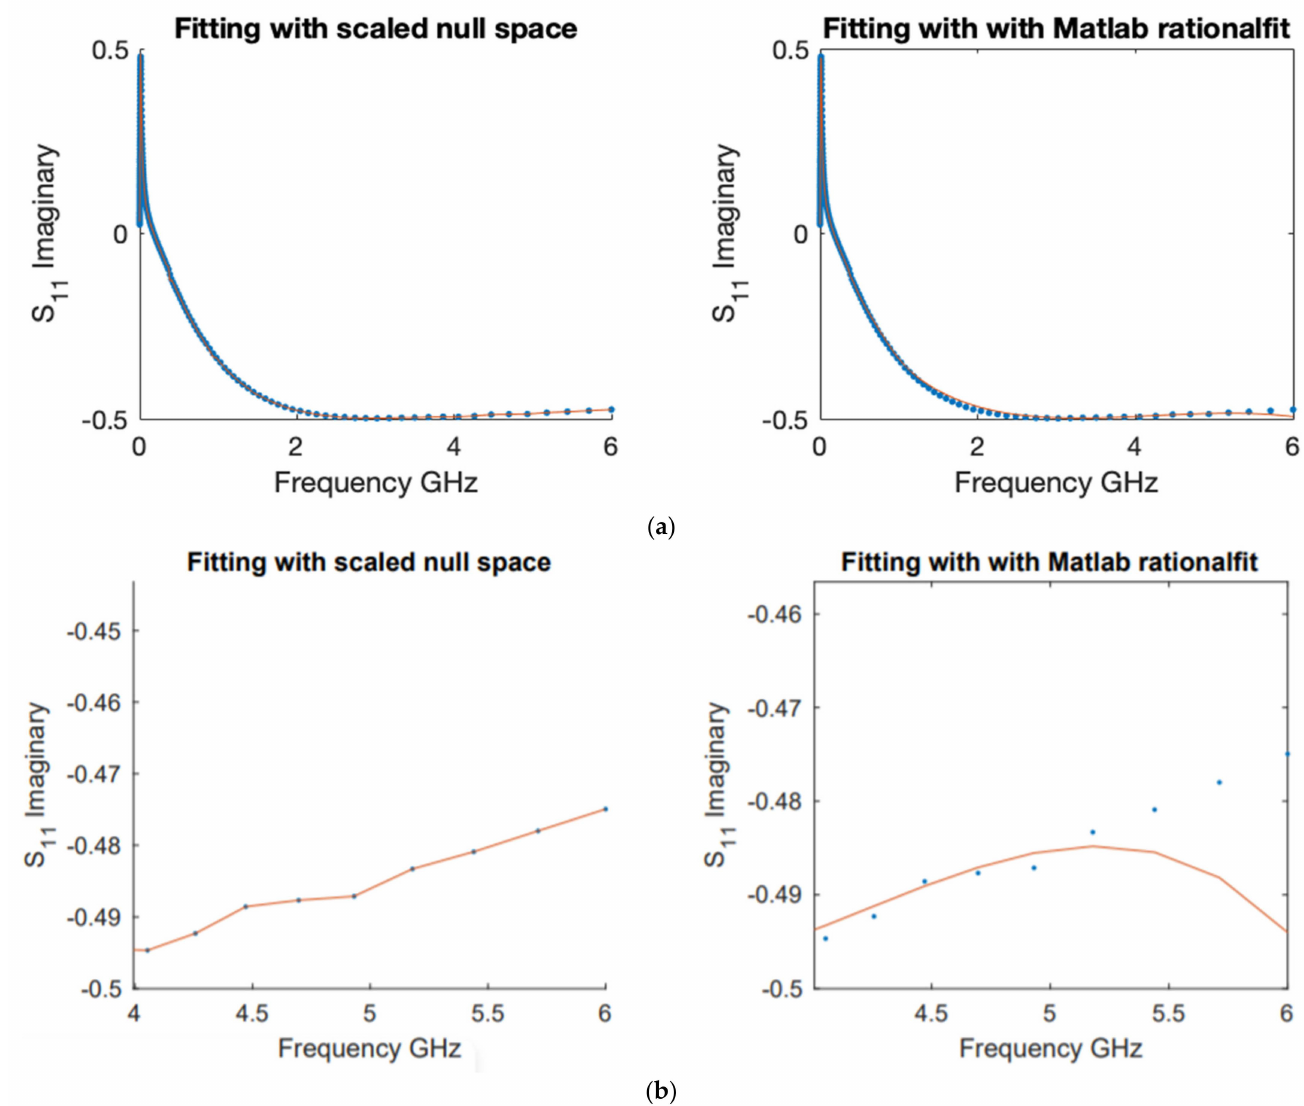
Figure 8. ( a ) Fitting imaginary part of s 11 parameter with scaled null space method on left and with Matlab rationalfit on right. Number of measurement data ( s , Im( s 11 )) is m = 202. Again, a higher accuracy is achieved when fitting with scaled null space method. ( b ) We have zoomed up ( a ) to show the differences between the two